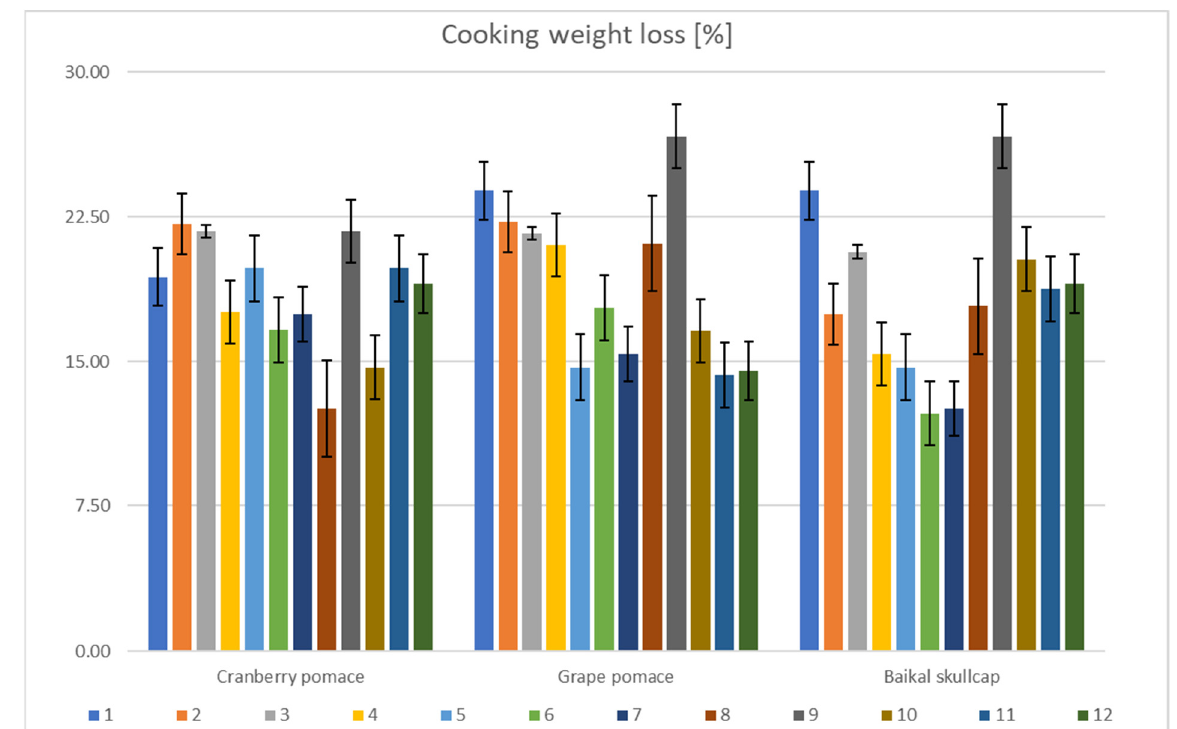
Figure 5. Changes in thiobarbituric acid reactive substance (TBARS) across the various marinated oven-grilled chicken breast meat samples. Results are expressed as mean ± standard deviation (SD) at the probability level of p < 0.05. The numbers (shown along the x -axis) represent as follows: (1) control before oven-grill; (2) AS before oven-grill; (3) IM before oven-grill; (4) control after oven- grill; (5) AS after oven-grill; (6) IM after oven-grill; African spice: AS; and industrial marinade/pickle: IM.